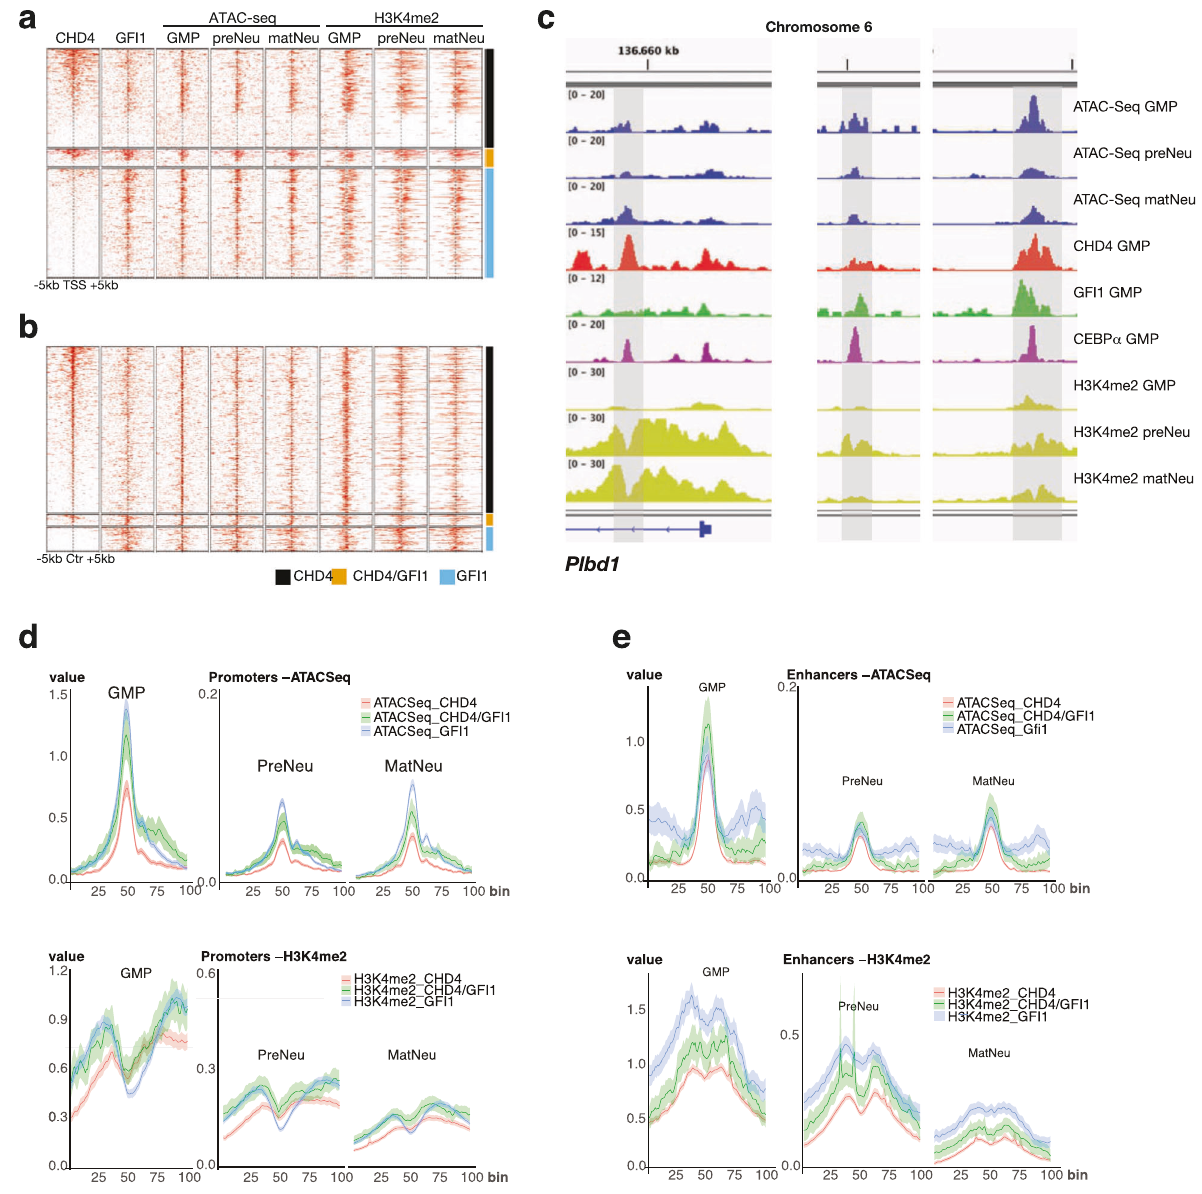
Fig. 6 H3K4 methylation and chromatin status at sites occupied by GFI1, CHD4, or both CHD4 and GFI1 during neutrophil differentiation. a Heatmap of data from ChIP-Seq and ATAC-Seq experiments and to determine the occupation of GFI1, CHD4, and H3K4 di-methylation patterns during neutrophil differentiation from GMPs via preNeu (preneutrophils) to matNeu (mature neutrophils). Data were fi ltered for promoter regions, ordered according to CHD4 occupation, and were separated into three groups: occupation by CHD4 alone, by GFI1/CHD4 and by GFI1 alone. b Heatmap of data from ChIP-Seq and ATAC-Seq experiments as in ( a ), but for enhancer regions. c ATAC-Seq and ChIP-seq read on loci covering the myeloid-speci fi c enhancers at the 3 ′ end of the Plbd1 gene and at downstream regions for sites occupied by GFI1, CHD4, or both, CEBPa and carrying the indicated histone marks. Annotations represent locations on the mouse genome version GRCm38 (mm10). d Metagene analysis for ATAC-seq reads and H3K4me2 levels ( e ) in RPM values for GMPs, preNeu, and matNeu cells at promoters occupied by CHD4 alone, by GFI1/CHD4, and by GFI1 alone. Shown are regions 2 kb 5 ′ and 3 ′ of the TSS. e Metagene analysis for ATAC-seq reads and for H3K4me2 levels in mean RKPB for GMPs, preNeu and matNeu cells at enhancers occupied by CHD4 alone, by GFI1/CHD4, and by GFI1 alone. Shown are regions 2 kb 5 ′ and 3 ′ of the site of the enhancer